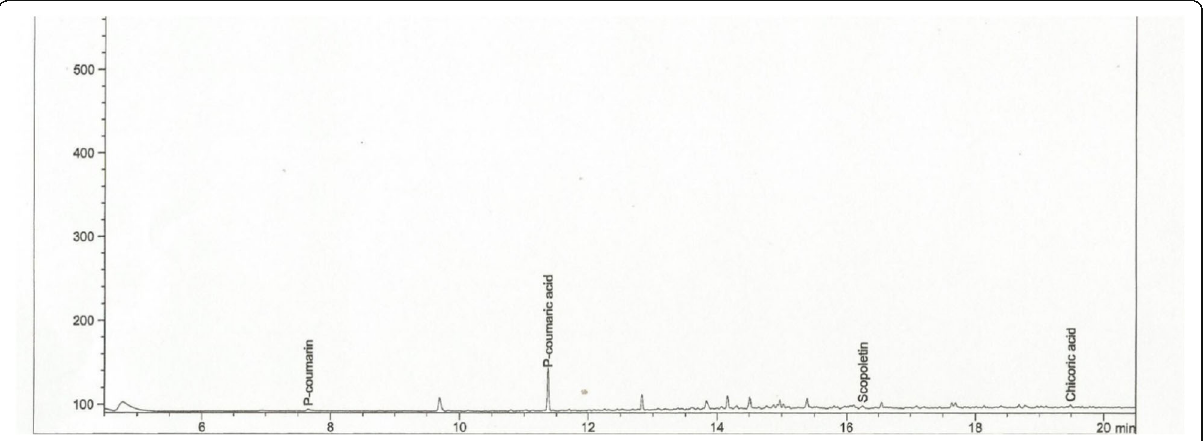
Fig. 2 GC Chromatogram showing the “ hydrocinnamic acids derivatives ” of ethyl acetate fraction of P . biglobosa